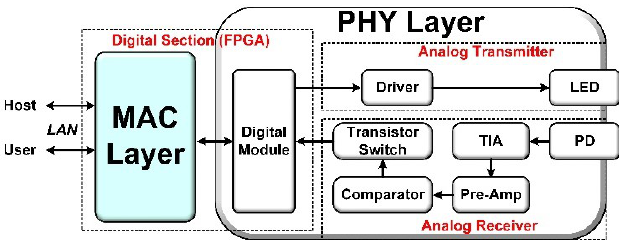
Figure 4. Block diagram of the overall VLC system Referred from Figure 4 , the complete